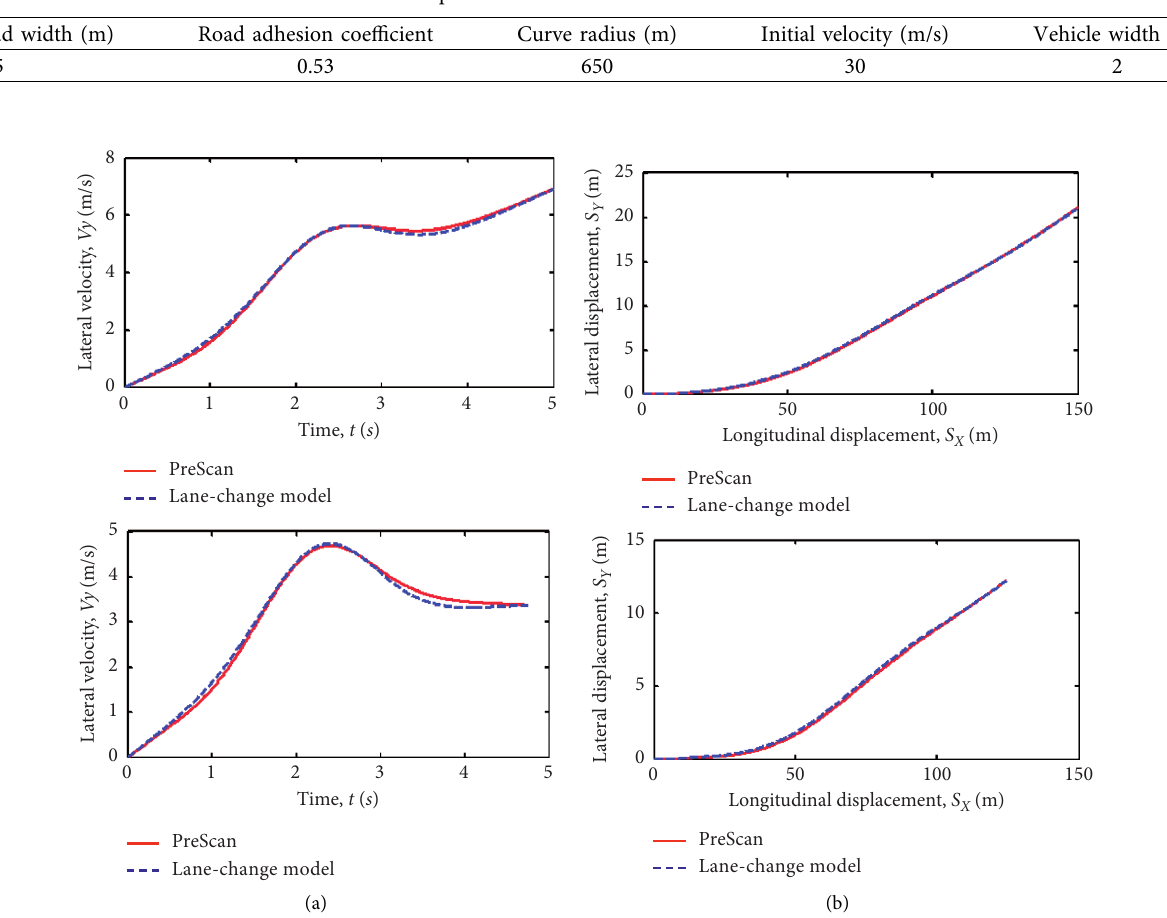
Table 1: Basic parameters of the simulation vehicle and road.